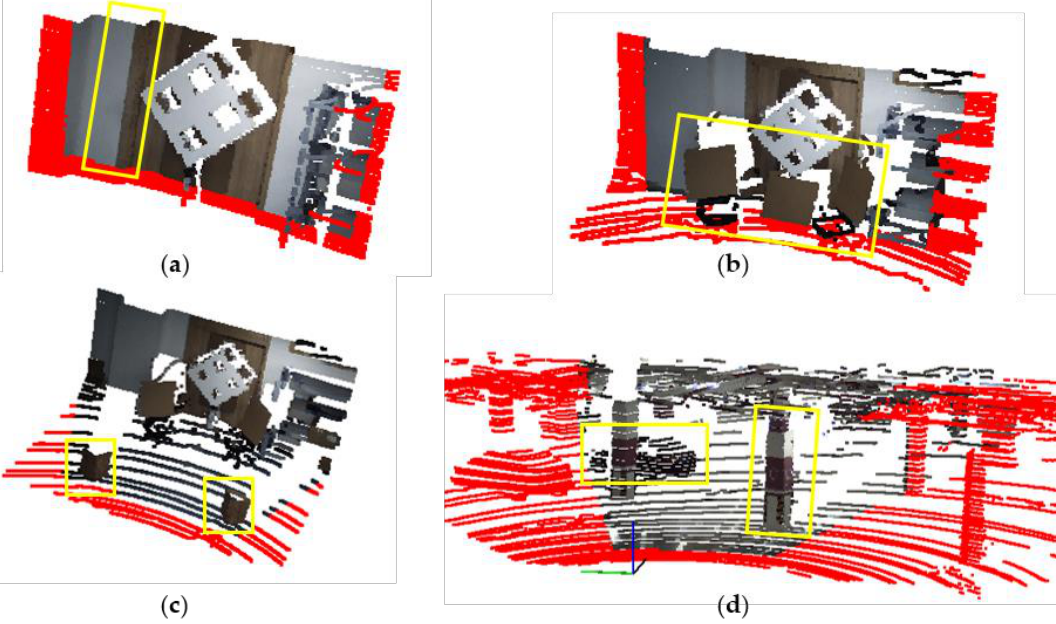
Figure 17. Results of 3D reconstruction effect. The test distances of ( a – c ) are 3.0 m, 5.0 m, and 7.0 m, respectively, ( d ) is the test result of outdoor scene. The red point is the point in the non-common FOV of the LiDAR and camera. The contents in yellow rectangles can provide detailed reference.